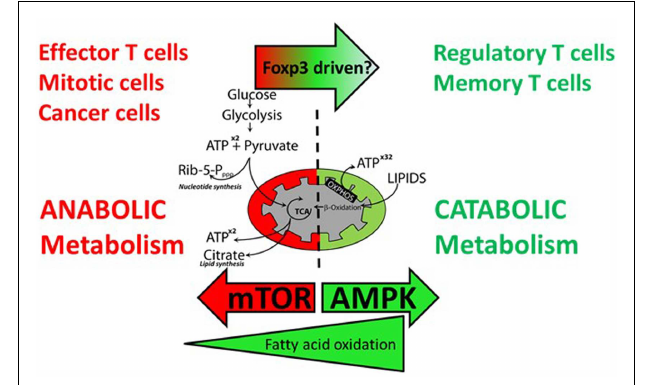
FIGURE 4 | EffectorT cells and regulatoryT cells have different requirements for anabolic and catabolic metabolism . EffectorT cells, proliferatingT cells, and cancer cells favor anabolic metabolism using aerobic glycolysis to fuel energy and cell mass demands during proliferation. Activation of mTOR drives this metabolic shift. Precursors for nucleotide synthesis and lipid synthesis are supplied via the pentose phosphate pathway and theTCA cycle, respectively. Resting regulatory and memoryT cells do not require glycolysis andTCA intermediates for cell growth and favor catabolic metabolism fueled by β -oxidation of fatty acids to fuel oxidative phosphorylation. Inhibition of mTOR and activation of AMPK favor a shift to catabolic